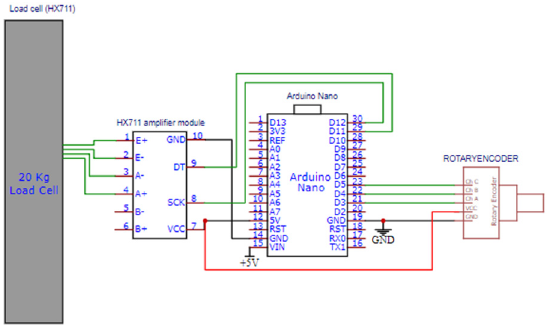
Figure 6. The schematic diagram for the force and displacement assessment.